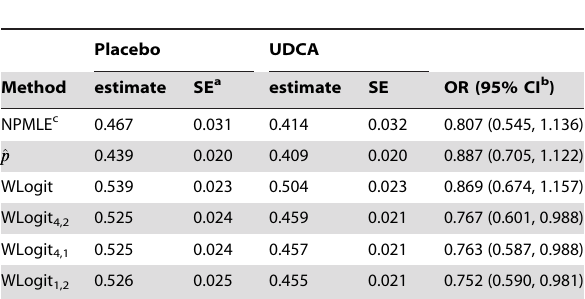
Table 2. UDCA Study: Estimation of recurrence rate for placebo and UDCA groups at 3